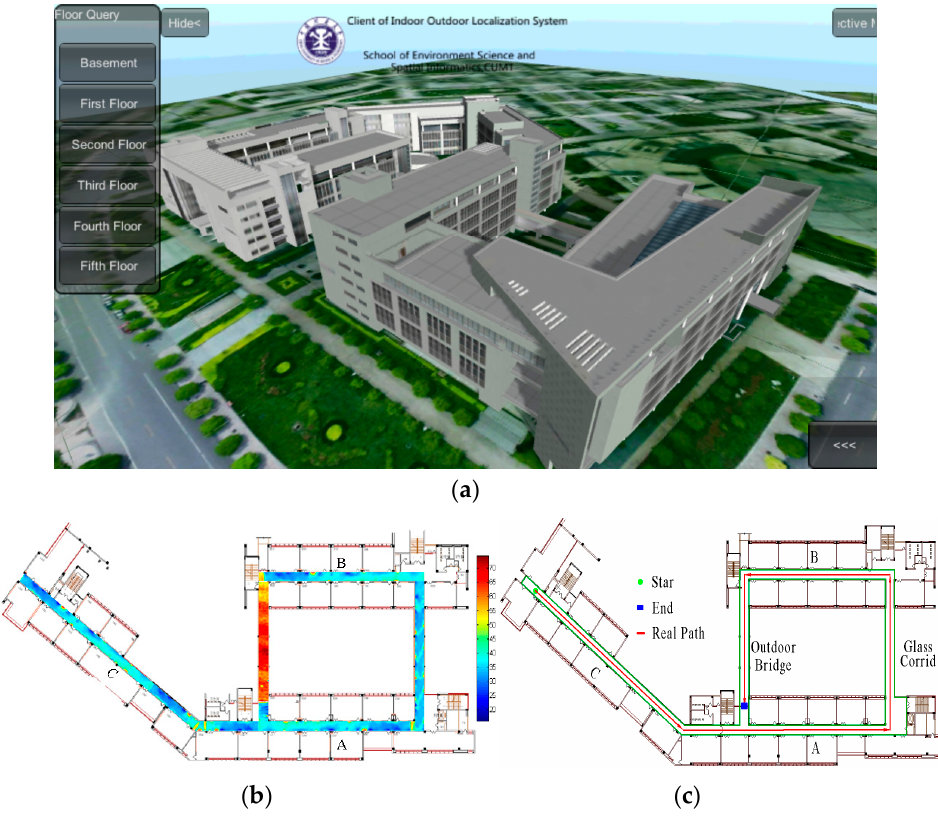
Figure 10. Indoor positioning experimental site: ( a ) 3D model of the experimental site; ( b ) the strength heat map of the magnetic field in the test area; ( c ) the path of the indoor positioning test.